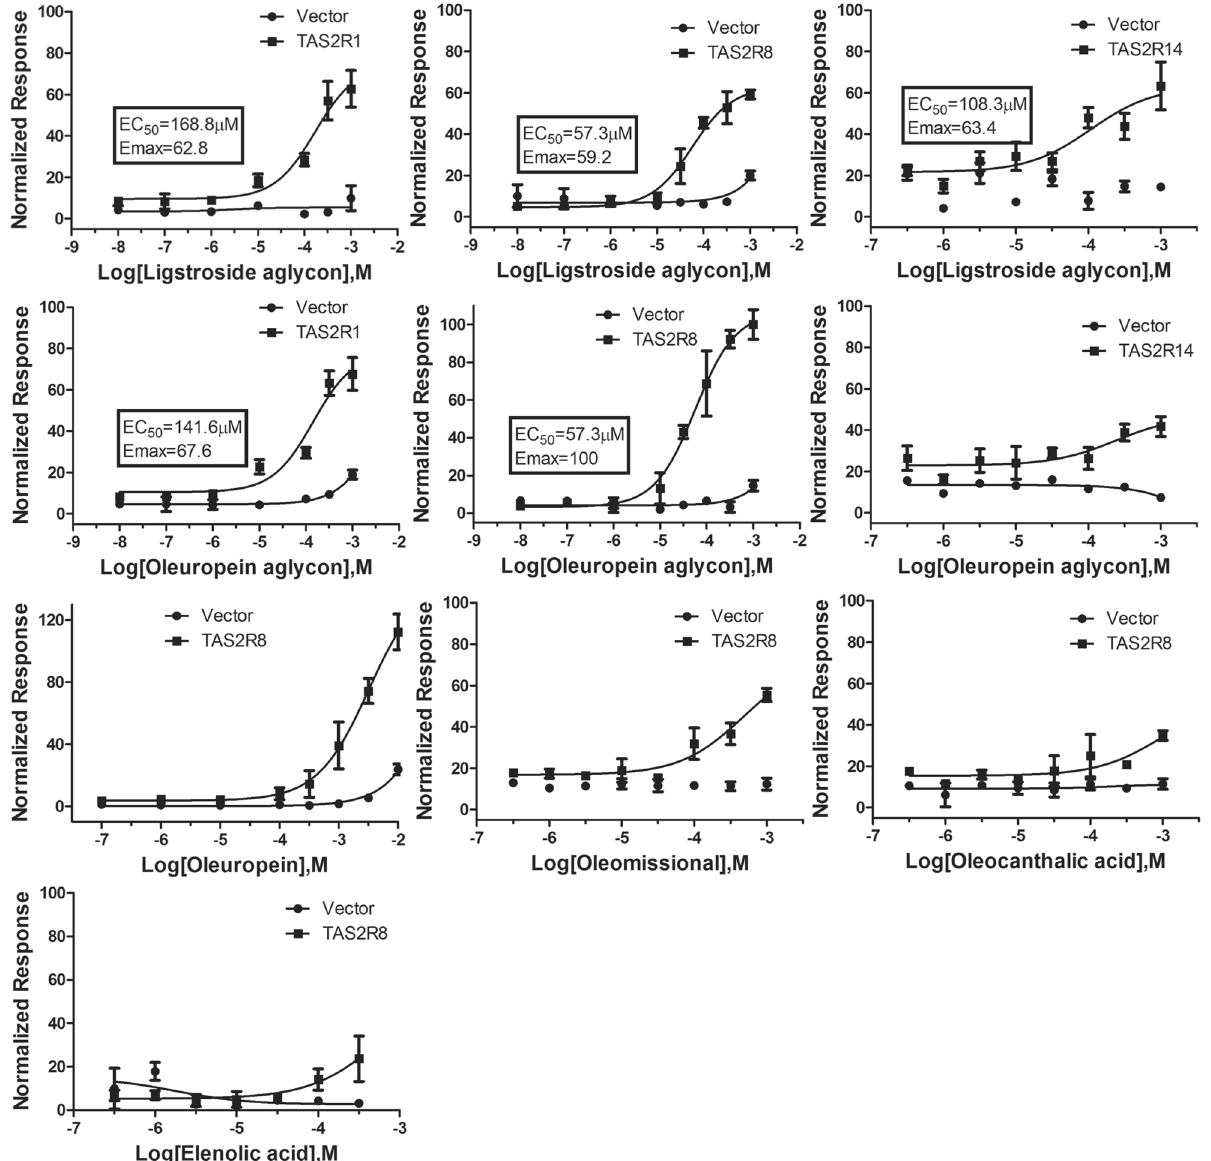
Figure 4. Dose–response curves of olive oil phenolics for bitter taste receptors, TAS2R1, TAS2R8 and TAS2R14. The fluorescence signals were normalized to the highest response of TAS2R8 to oleuropein aglycon (100%) (N = 3). Data represent mean ±